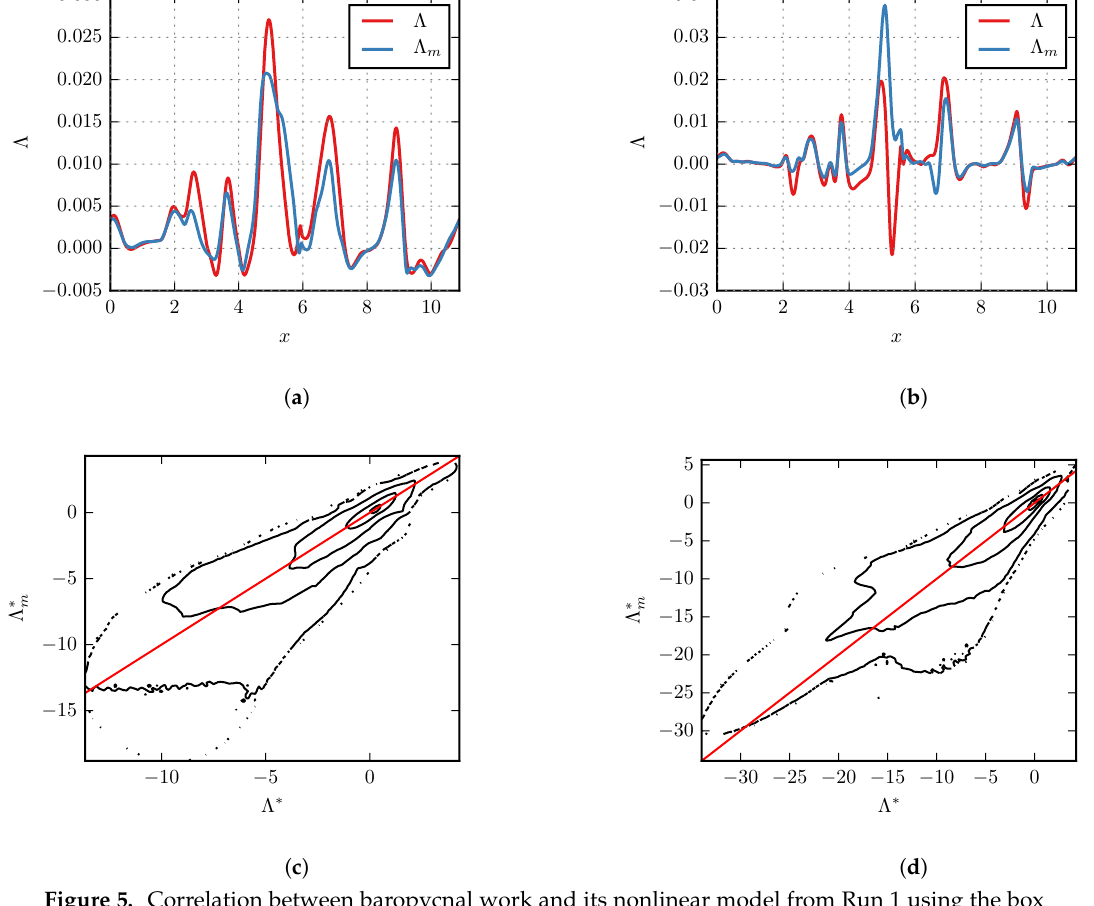
Figure 5. Correlation between baropycnal work and its nonlinear model from Run 1 using the box kernel with filter scale k (cid:96) = 8 in ( a , c ) and k (cid:96) = 16 in ( b , d ). Top two panels plot Λ and Λ m along a diagonal line through the domain from a single snapshot. Lower two panels show time-averaged isocontours of the logarithm of the joint PDF between Λ and Λ m, where star superscripts indicate that means have been subtracted and the values are normalized by their variance. Straight-red lines are y = x . The correlation coefficients are R c = 0.93 at filter scale k (cid:96) = 8 and R c = 0.94 at k (cid:96) = 16. All four panels indicate excellent correlation between Λ and Λ